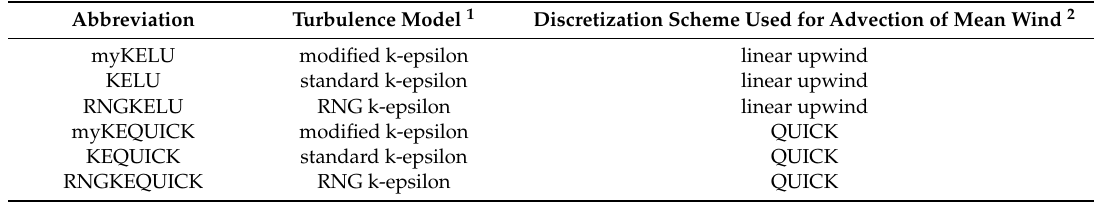
Table 2. Computational fluid dynamic (CFD) settings